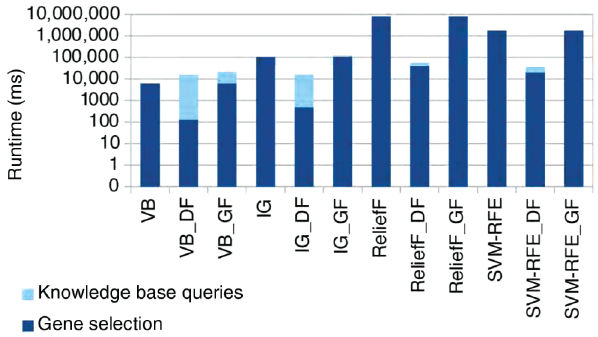
Figure 9: Runtime performances of traditional gene selection approaches compared to data and gene filtering with exter- nal knowledge bases.